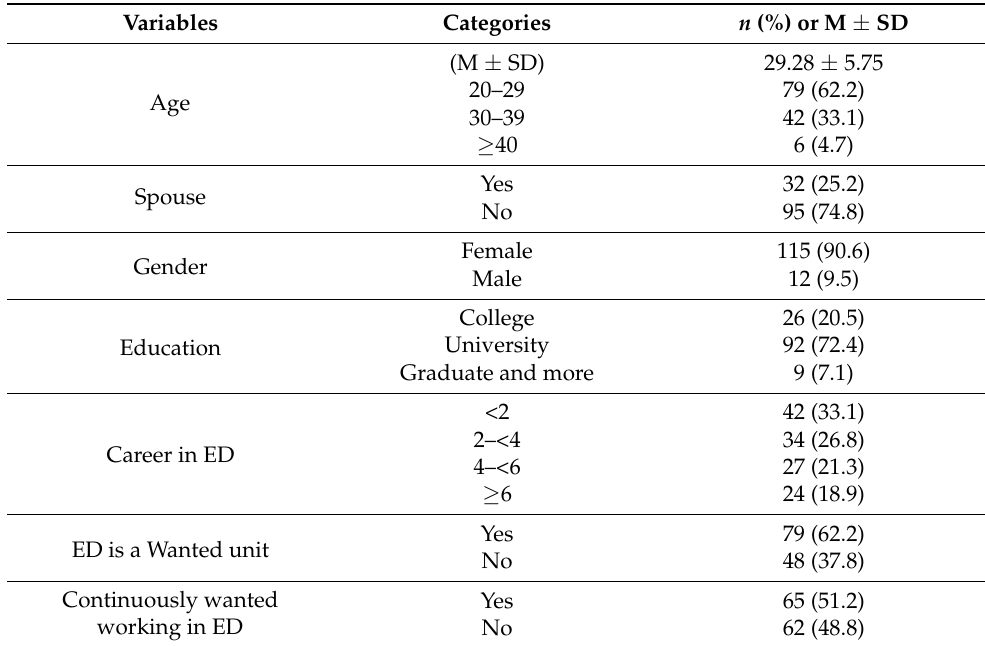
Table 1. General characteristics of the subject ( n = 127).